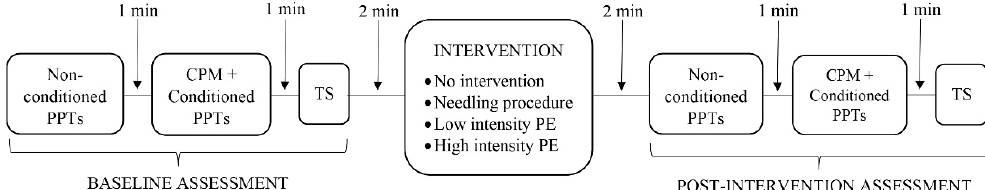
Figure 1. Experimental protocol timeline. PPTs: pressure pain thresholds; CPM: conditioned pain modulation; TS: temporal summation; PE: percutaneous electrolysis.